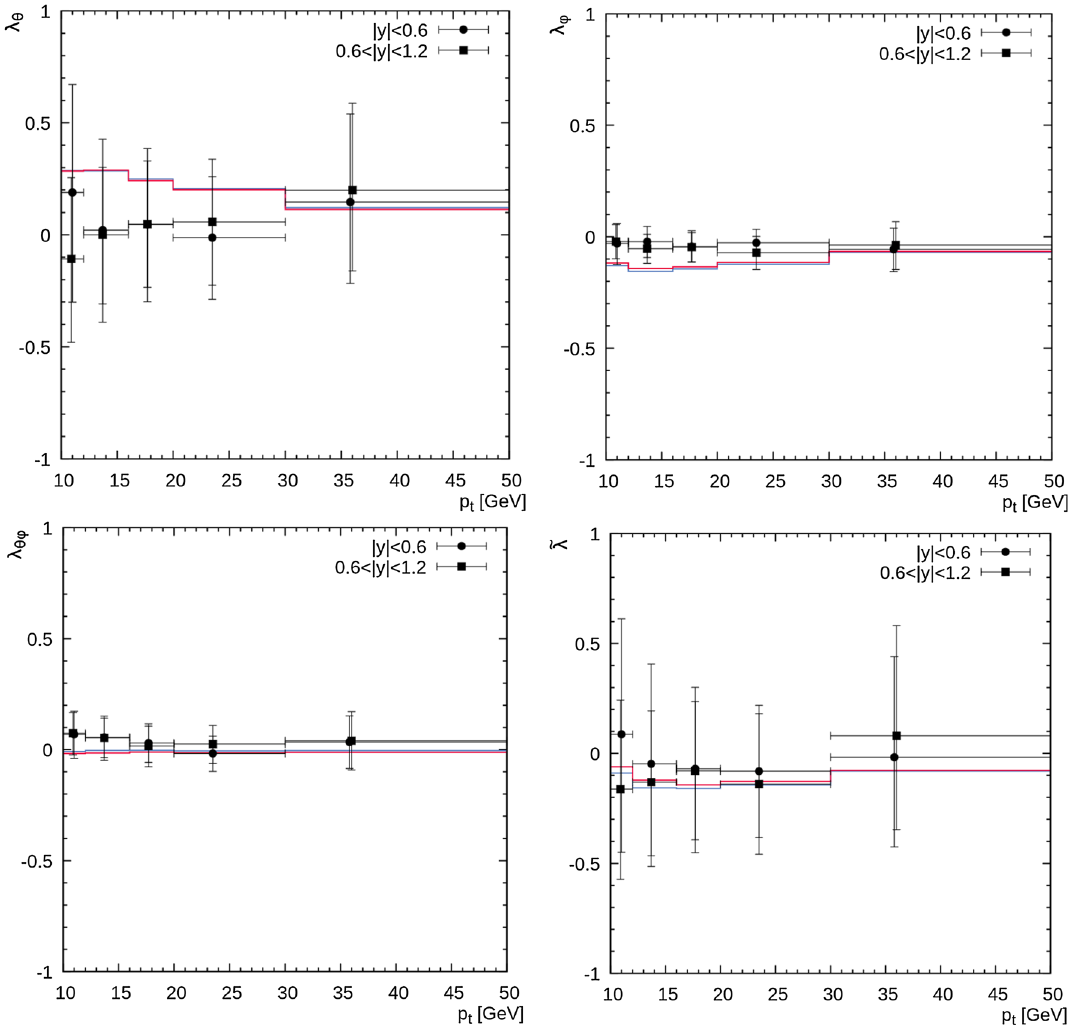
Fig. 13 The polarization parameters λ θ , λ φ , λ θφ and ˜ λ of the ϒ( 1 S ) mesons calculated in the perpendicular helicity frame as functions of its √ s = 7 TeV. The notation of all histograms is the same as in Fig. 11. The experimental data are from CMS transverse momentum at